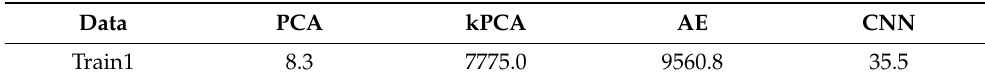
Table 3. The processing CPU times (in